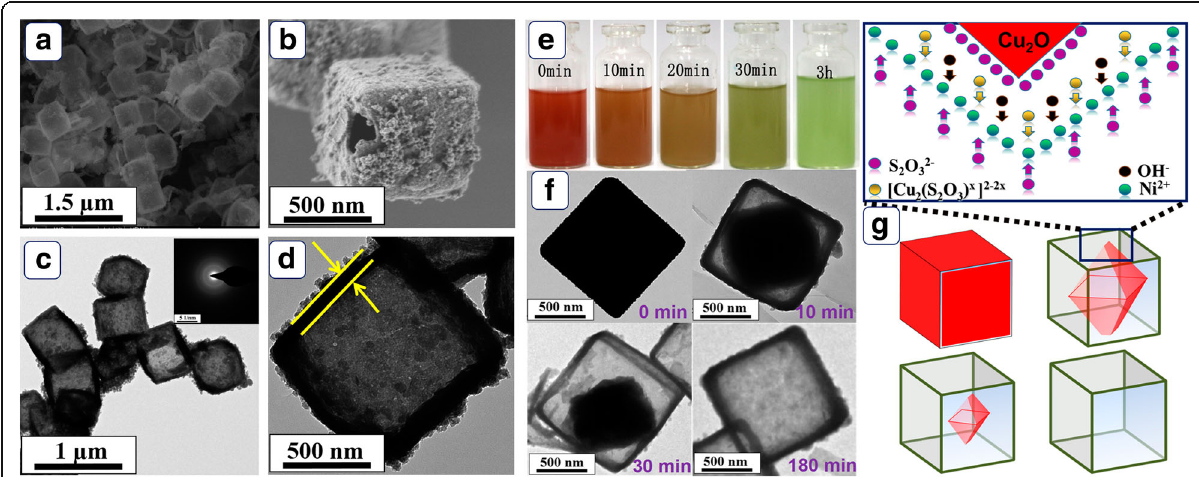
Fig. 2 a , b SEM and c , d TEM images of the Ni(OH) 2 HPA; inset of c is the SAED pattern of Ni(OH) 2 HPA. e Optical photographs of the reaction solution at different time after addition of etchant. f TEM images of the products monitored at different reaction time. g Schematic illustration of